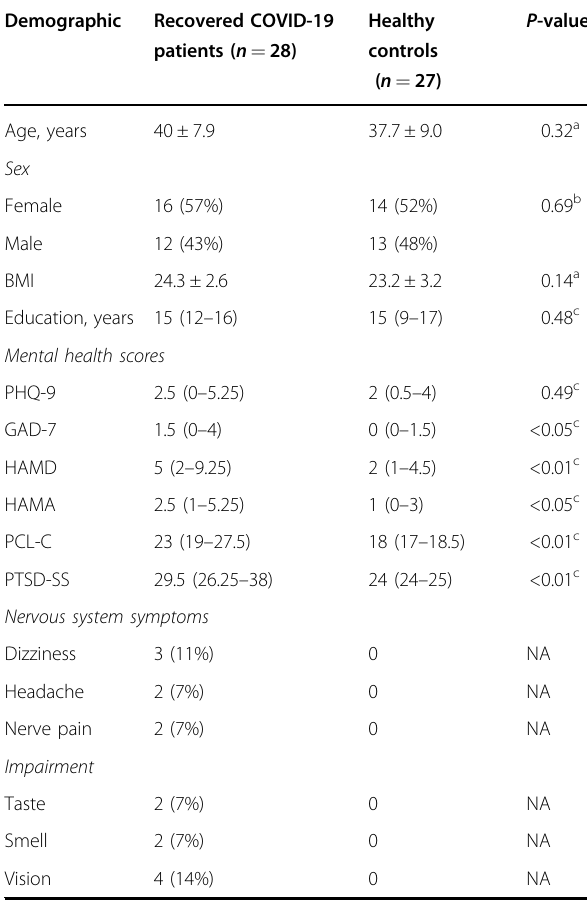
Table 1 Summary of the demographic and clinical